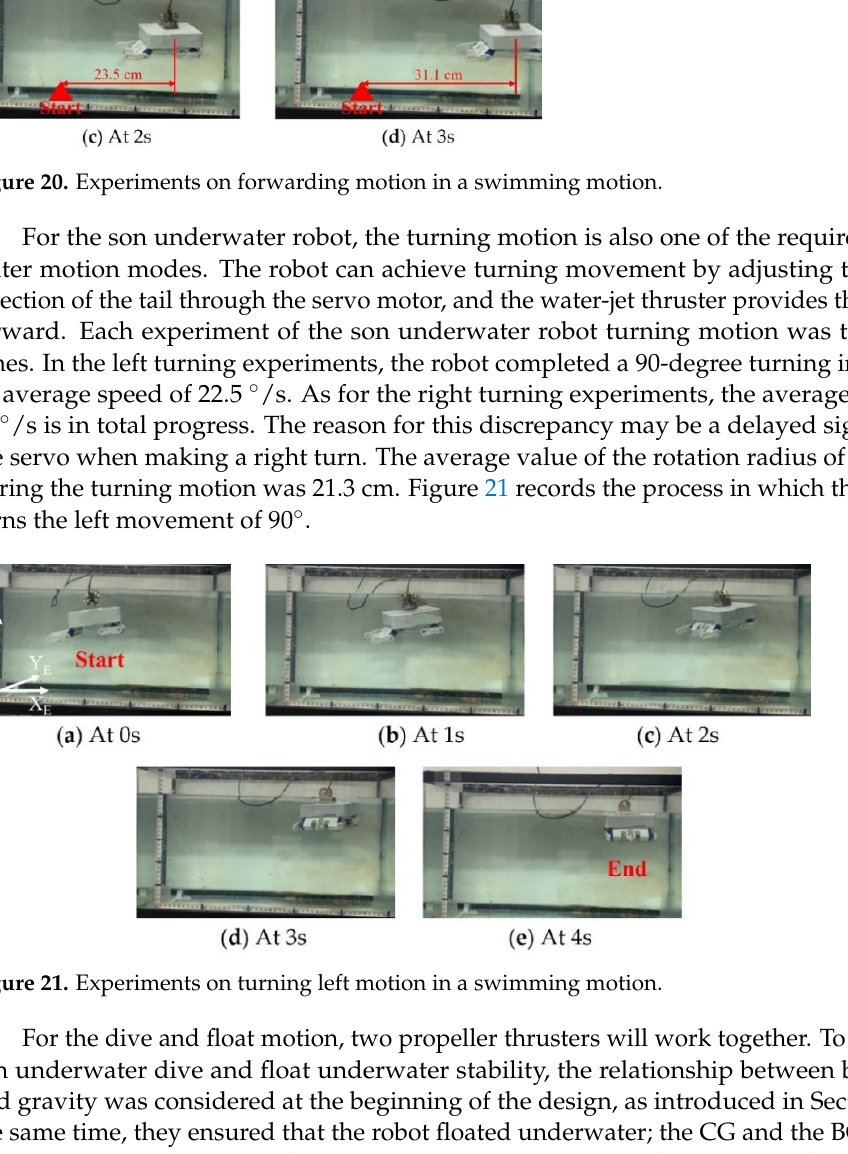
Figure 22. Experiments on floating motion in a swimming motion.